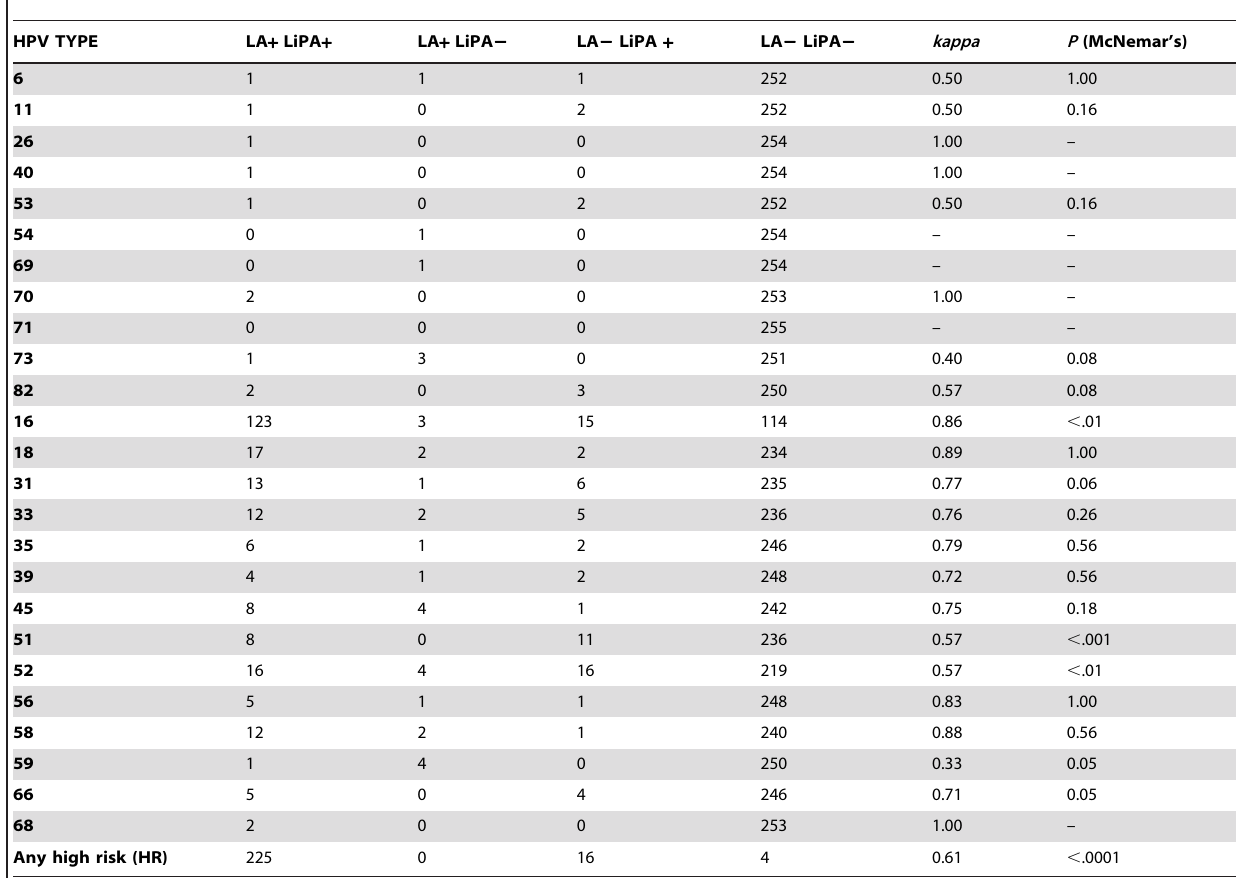
Table 1. Concordance between Linear Array (LA) and LiPA test results for HPV types included in both assays.